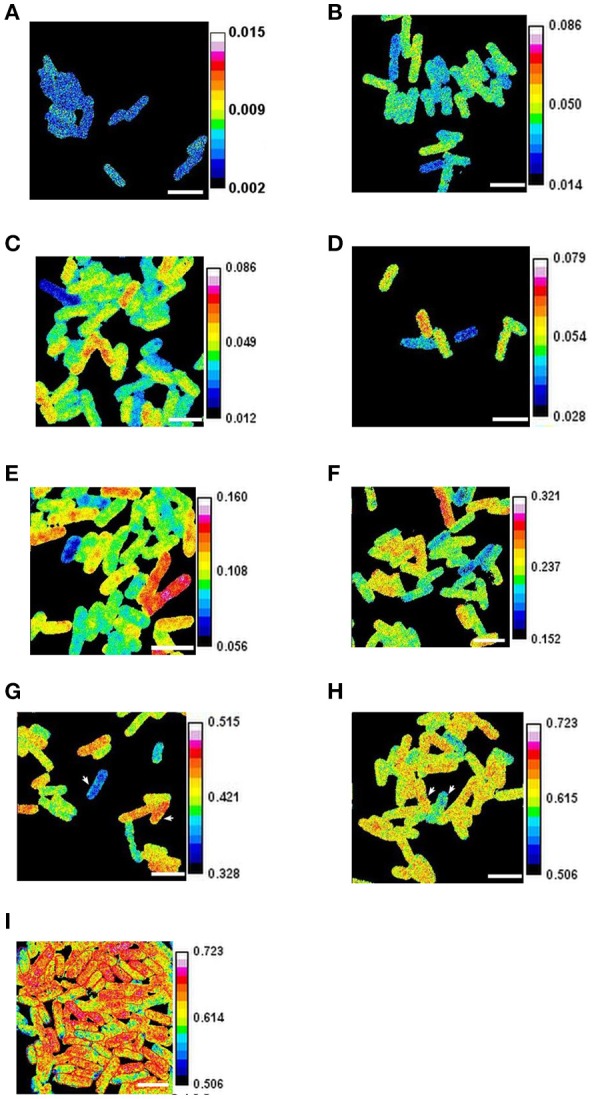
Heterogeneous growth of E. coli. Cells growing in steady state (after 15 generations of growth at an OD600 below 0.1) were labeled with 90% 15N for periods of (A) 0 min. (B) 2 min. (C) 4 min (D) 8 min. (E) 16 min. (F) 32 min. (G) 64 min. (H) and (I) 128 min. In (I) the cells were fixed with formaldehyde and some outlined for analysis. The ratios of 12C15N/(12C14N+12C15N) were obtained with a NanoSIMS 50. The arrowheads show cells with mass doubling times estimated using isotope incorporation as 61 min and 82 min in (G), and as 70 min and 80 min in (H). Scale bars 2 μm.